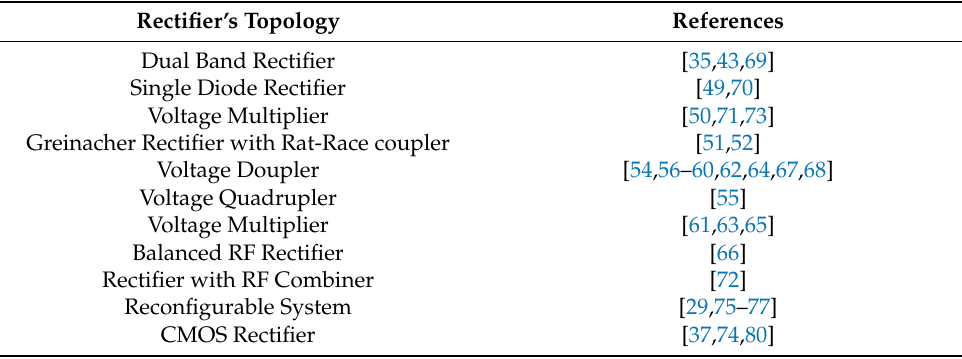
Table 6. List of rectifiers based on their topology.